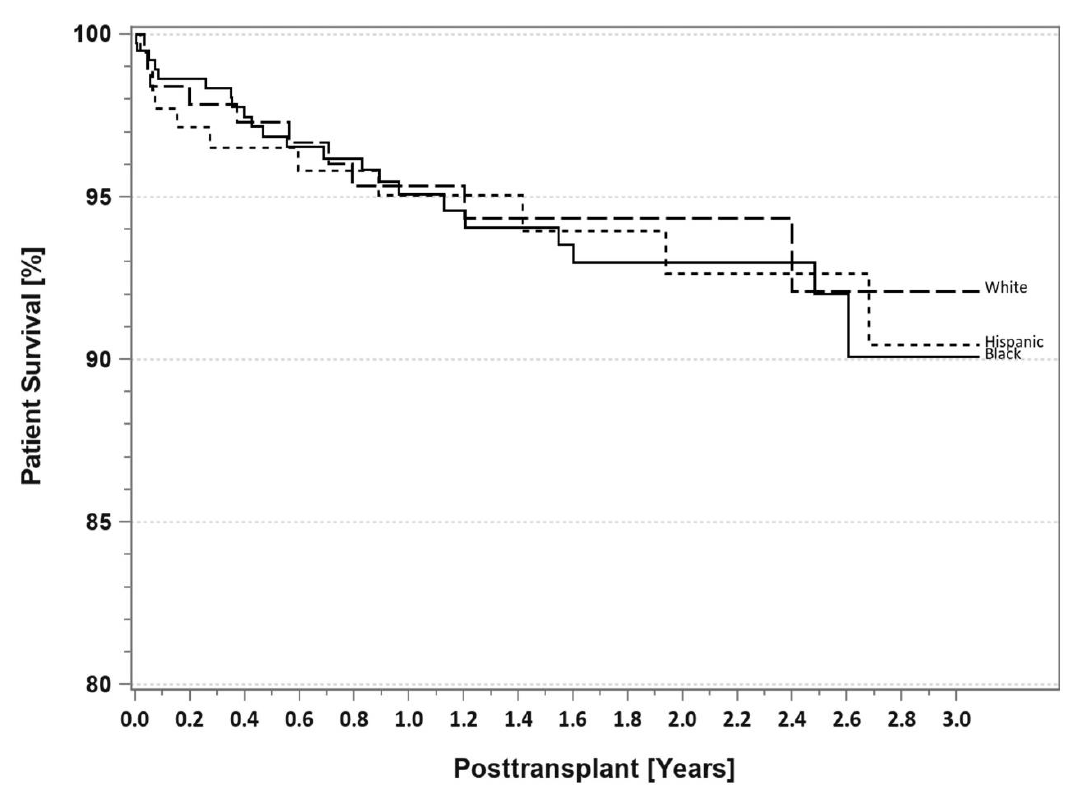
Figure 12. SPKT patient survival according to recipient race in patients identified as having T2DM in